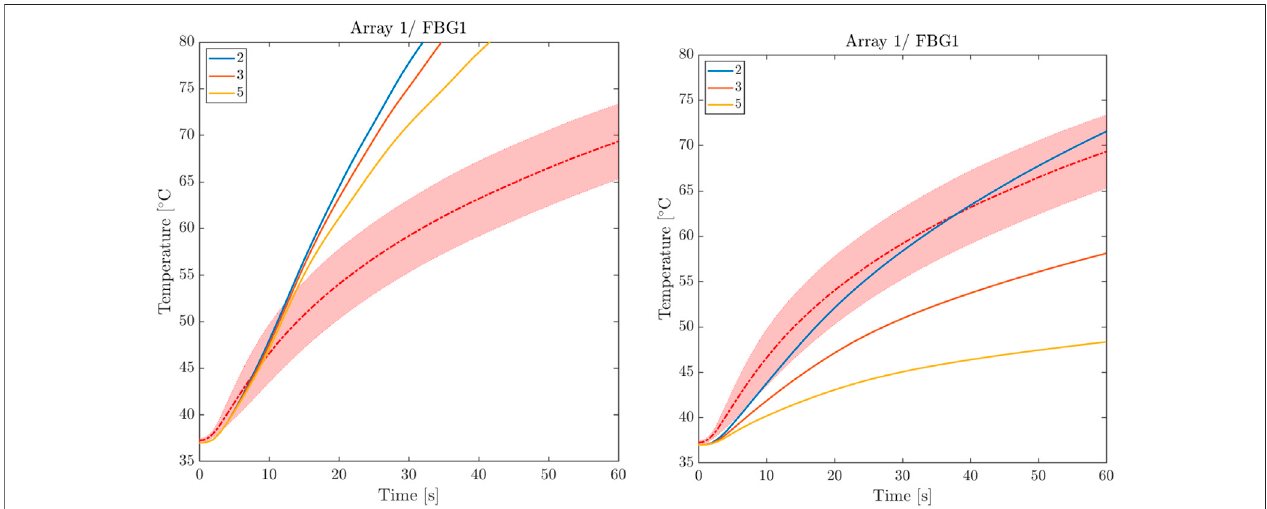
FIGURE8| Comparison between thermal and electrical anisotropy fi tting.Left: thermal isotropy forthree levels of electrical anisotropy.Right:electricalisotropy for three levels of thermal anisotropy.